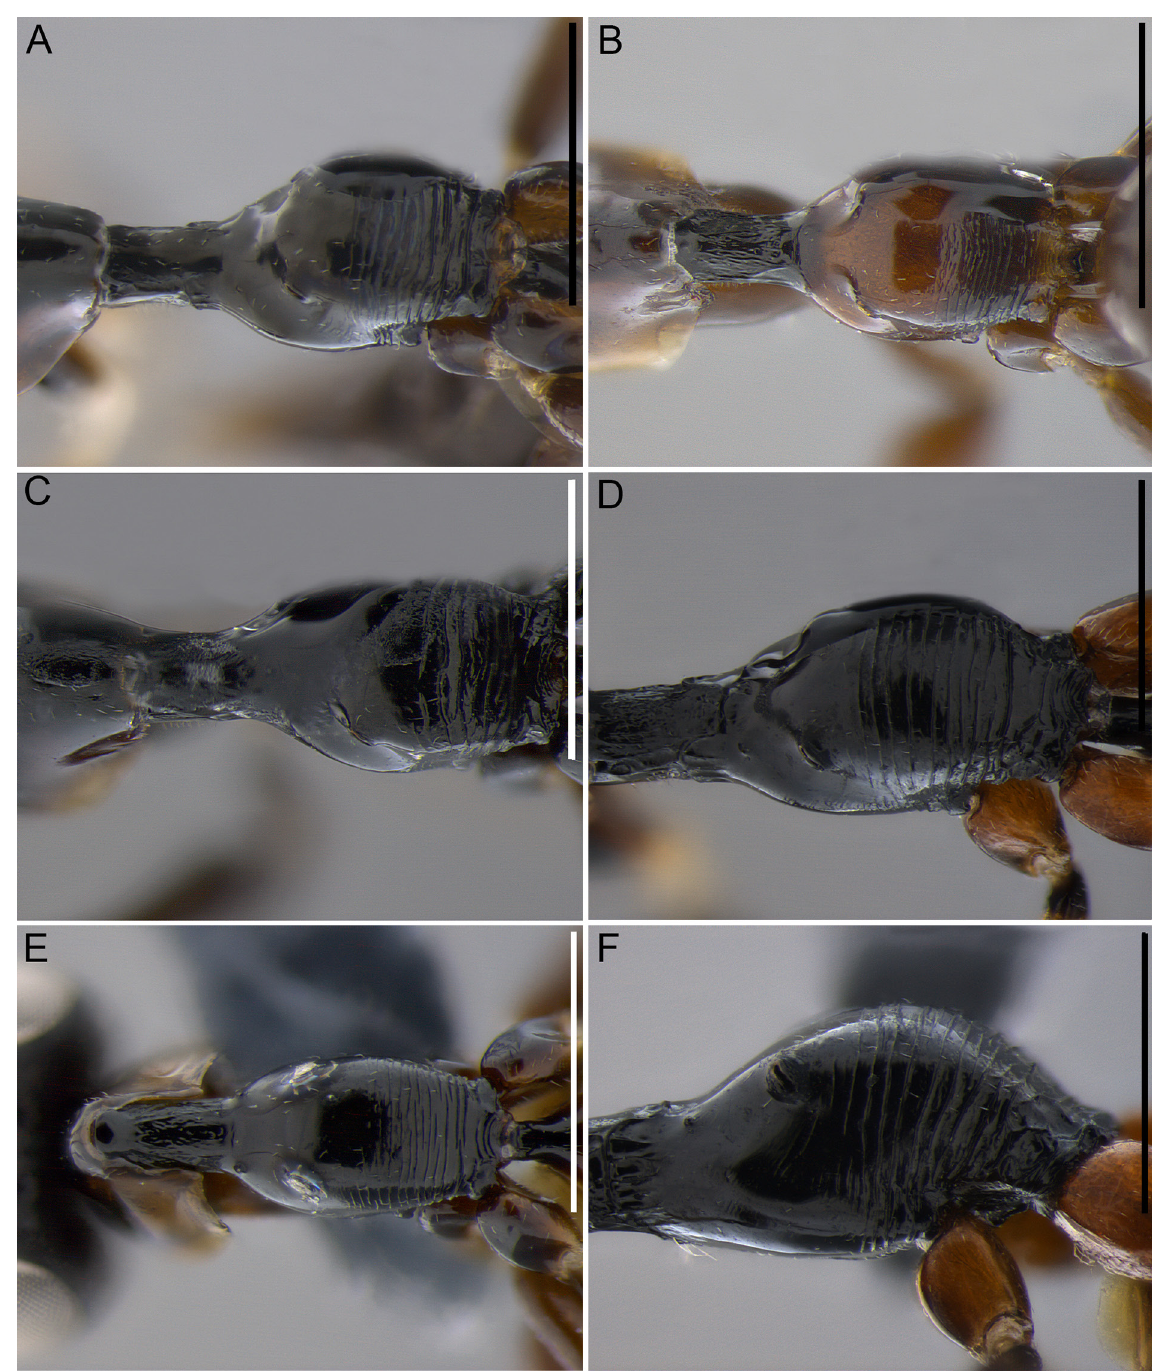
Fig. 9. Mesosoma in dorsal and lateral view of species of Pareucamptonyx Olmi, 1991. A . P .